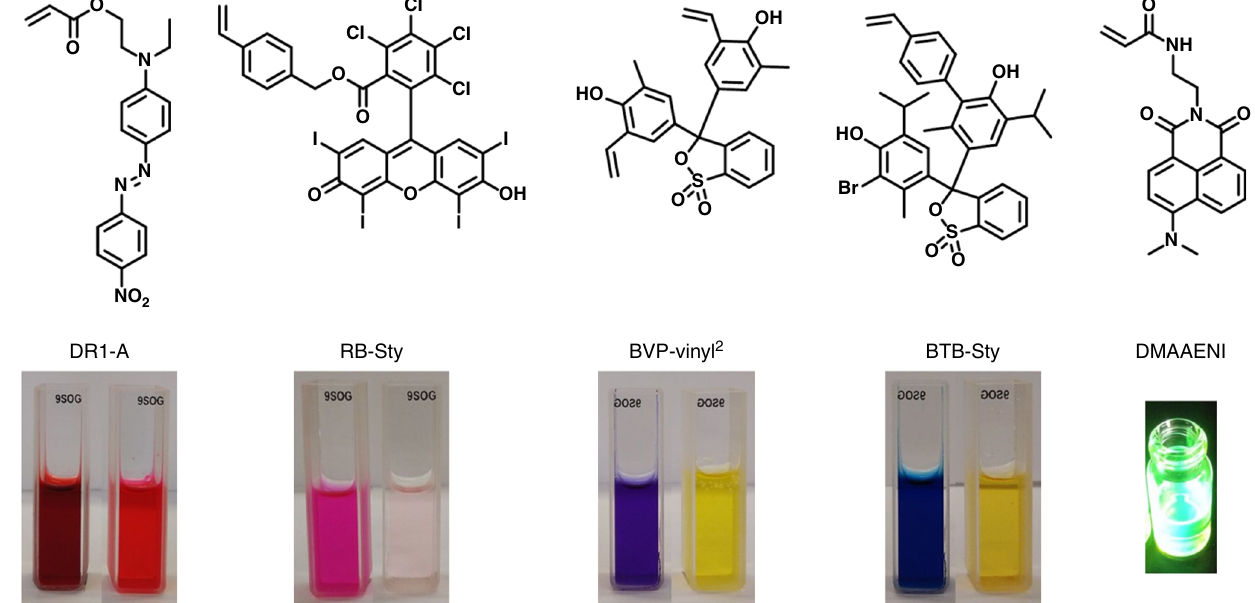
Fig. 5 Overview of the structure, abbreviations, and visual properties of the used dyes. DR1-A, RB-Sty, BCP-vinyl 2 , and BTB-Sty show halochromic properties from acidic (left) to basic (right) while DMAAENI shows strong fl uorescence in